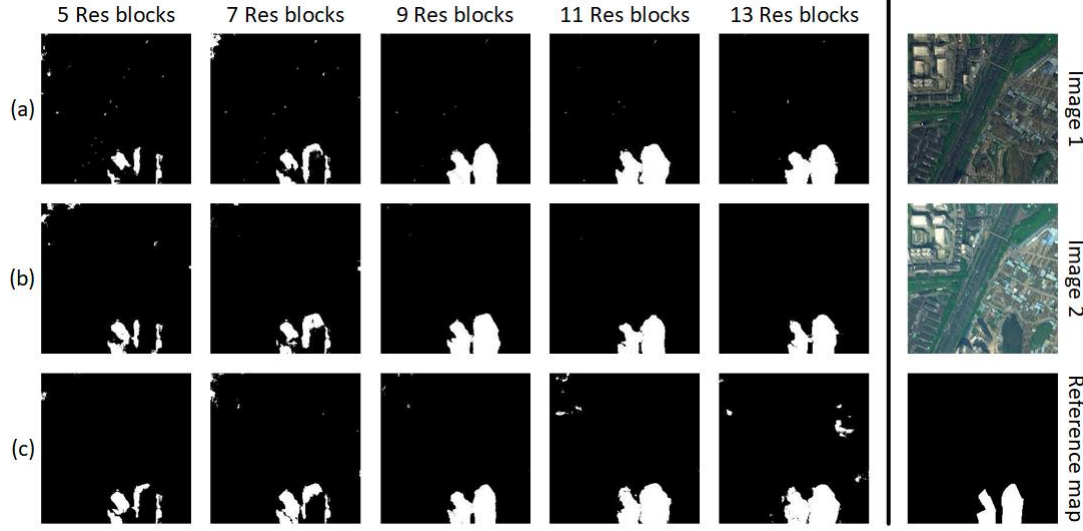
Figure 9. The representative change detection results affected by generators with diverse structures: ( a ) one down- and up-sampling layer, ( b ) two down- and up-sampling layers, ( c ) three down- and up-sampling layers.